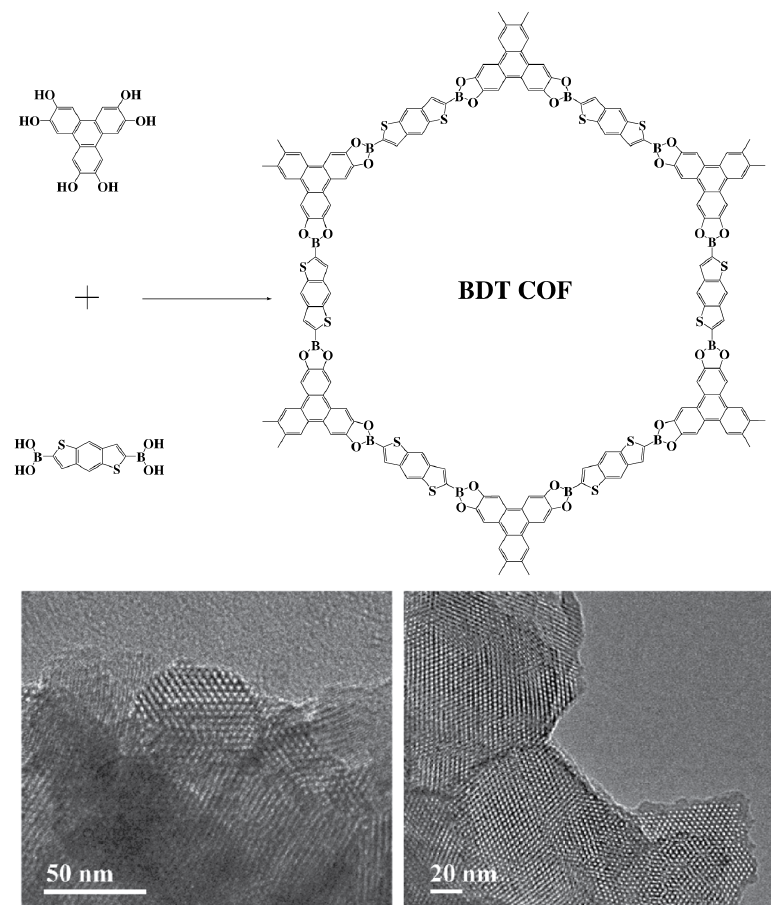
Figure 9: Synthesis reaction and TEM images of